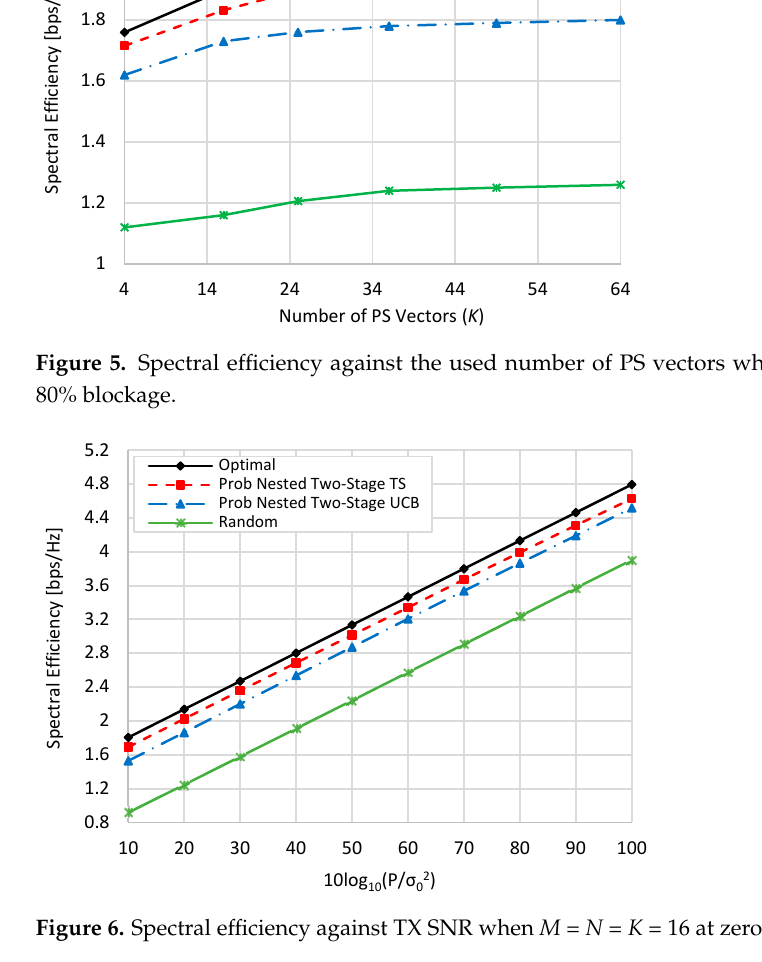
Figure 7. Spectral efficiency against TX SNR when N = 36 , M = 64 , and K = 16 at zero blockage. Figures 8 and 9 show the spectral efficiency convergence rate of the proposed nested two-stage MAB schemes against the time horizon 𝑡 using K = N = M = 16 at zero and moderate blockage effect with blockage probability of 50%, respectively. Due to the effect of blockage, the spectral efficiency performance given in Figure 9 is lower than that rep- resented in Figure 8. From these figures, it can be seen that the proposed nested two-stage TS has a faster convergence rate than the UCB-based one due to its Bayesian strategy. Interestingly, the proposed nested two-stage UCB has better convergence than the TS- based one at low values of 𝑡 , where the TS algorithm starts to build up the prior/posterior distributions of the achievable reward. As these distributions are constructed, the TS con- verges faster than UCB, as shown by these figures. At 𝑡 = 400 , about 99% (99%) and 95.12% (94.8%) of the optimal performance are obtained using the proposed nested two- stage TS and UCB-based one at zero (50%) blockage, respectively.